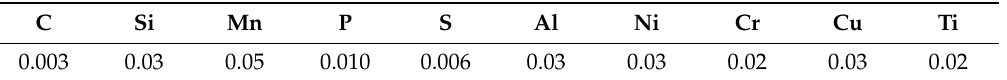
Table 1. Chemical compositions (mass